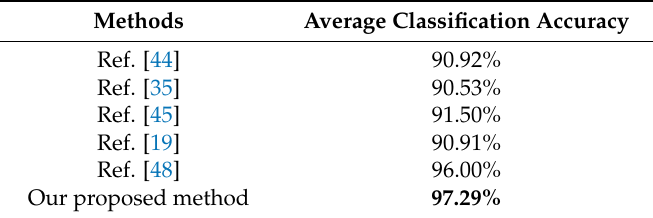
Table 4. Comparisons of the average classification accuracy on UTKinect-Action3D dataset.